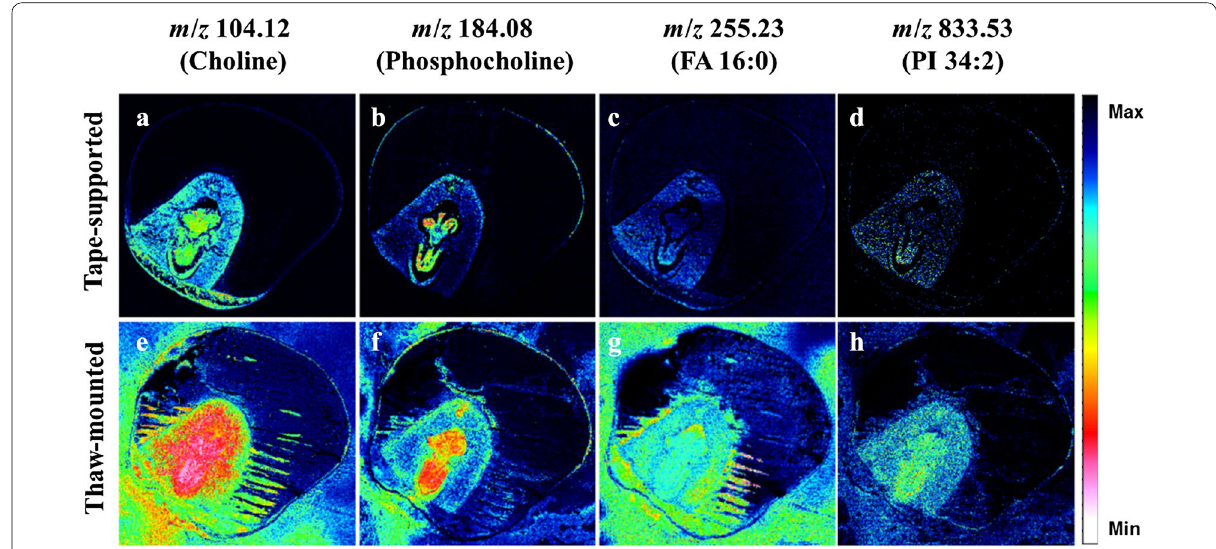
Fig. 4 ToF–SIMS images of corn seed tissue prepared by the adhesive tape-supported and thaw-mounted methods. Molecular distribution of a , e choline, b , f phosphocholine, c , g palmitic acid, and d , h phosphatidylinositol (PI) 34:2 (Reproduced from ref. [85] with permission, ©